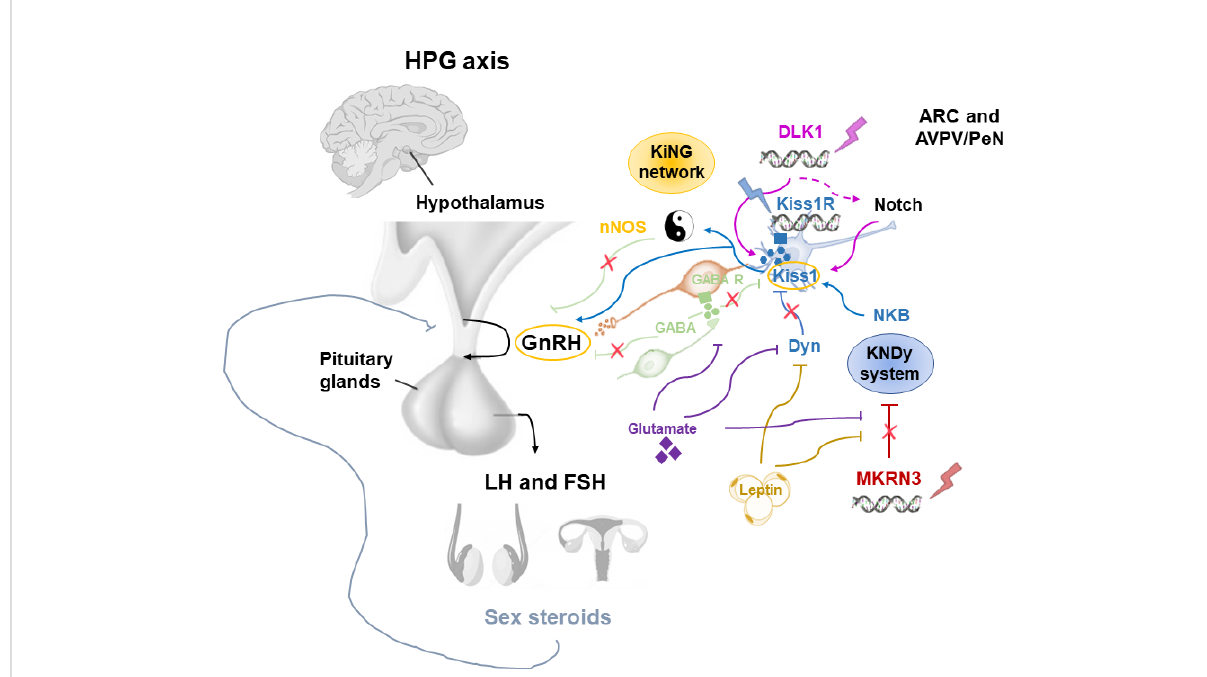
FIGURE 2 Modulation of the GnRH pulse generator by mechanisms in fl uencing the pubertal timing. ARC, arcuate nucleus; AVPN/PeN, anteroventral periventricular/periventricular nucleus; Dyn, dynorphine A; FSH, Follicle-stimulating hormone; GnRH, Gonadotropin Releasing Hormone; HPG, hypothalamic-pituitary-gonadal; KiNG network, Kisspeptin-nNOS-GnRH; Kiss1, kisspeptin; KNDy, kisspeptin/neurokinin B/dynorphine A; LH, luteinizing hormone; MKRN3, macorin-3; NKB, neurokinin B; nNOS, neuronal nitric oxide